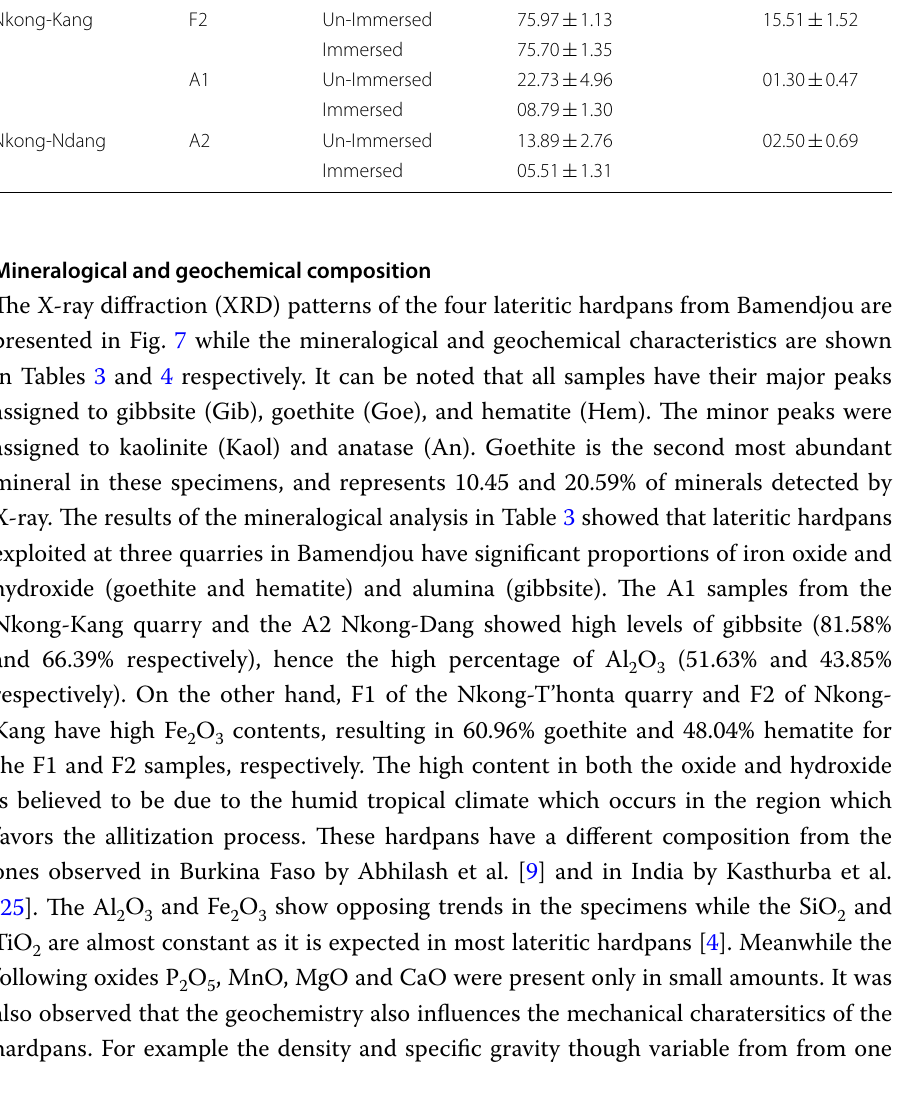
Table 4 Mechanical properties of the lateritic hardpan specimens of Bamendjou Quarry